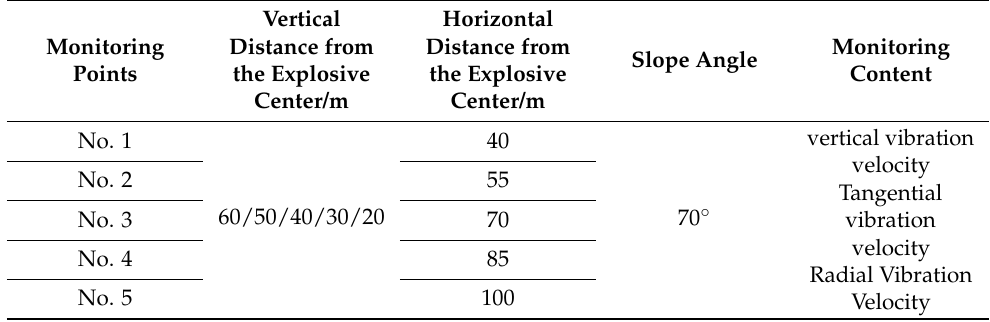
Table 2. The results of blast vibration monitoring.